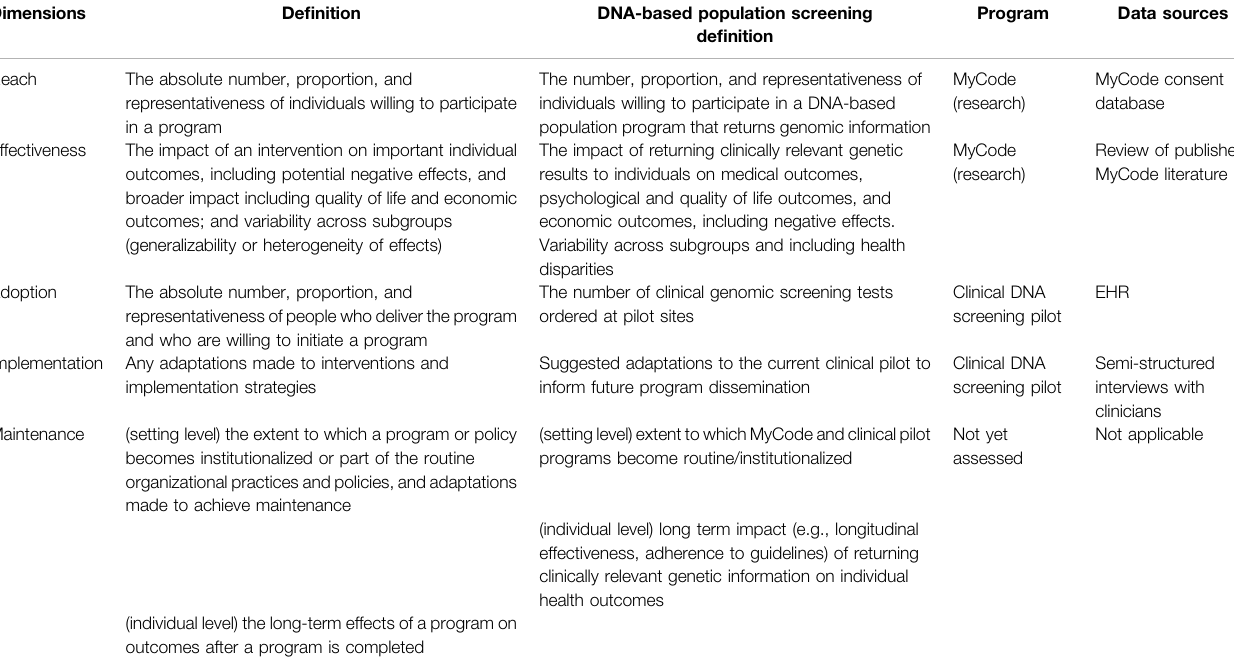
TABLE 2 | RE-AIM dimensions with standard de fi nitions, adapted de fi nitions, associated Geisinger DNA screening programs, and data sources.